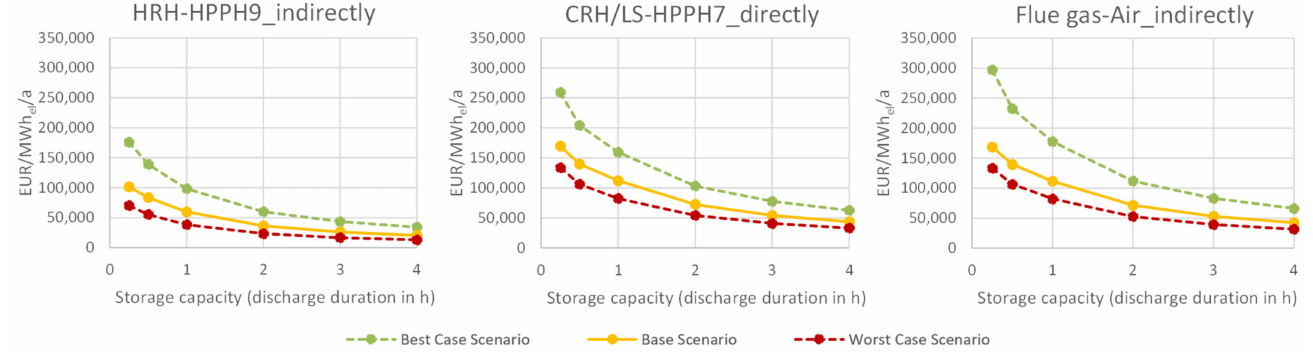
Figure 29. Specific profits through TES per year for different storage sizes (worst-case scenario in red, baseline scenarios in yellow, best-case scenario in